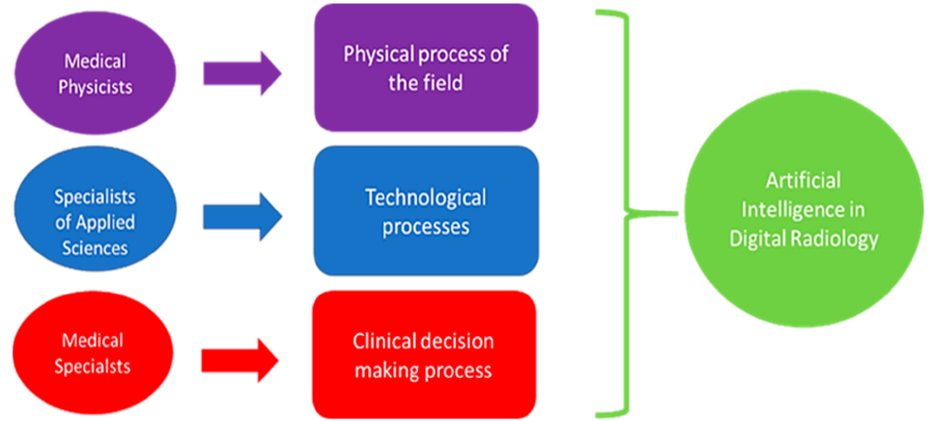
Figure 2. Interconnection among experts and AI.